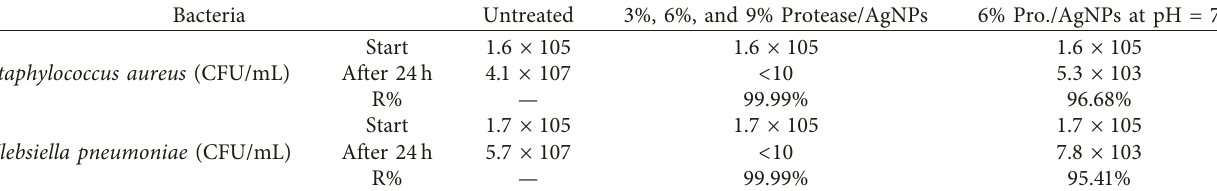
Table 1: The antibacterial performance of wool fibers.